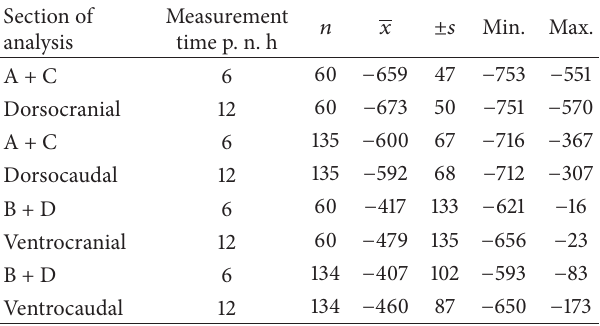
Table 5: Development of X-ray absorption values (HU) of the lung parenchyma of 15 vital calves (group A) compared between the sixth and twelfth hour of life.